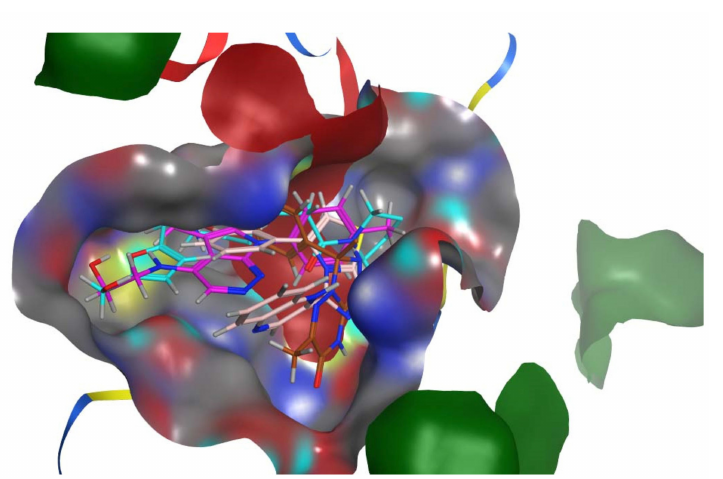
Figure 1. The M pro protein’s molecular surface representation with an overlay of all retrieved active hits in the binding pocket. The ZINC44928678, ZINC08535852, 12-quinoxaline derivative, and ChemBridge63310525 active ligands were represented by purple, dark brown, pink, and cyan colors,